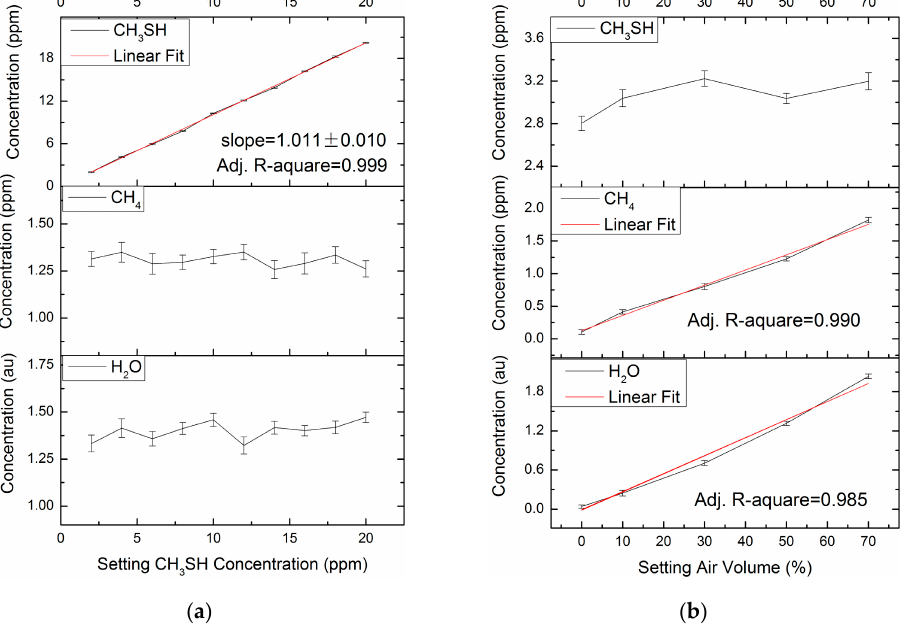
Figure 5. ( a ) Results of a group of mixtures with different CH 3 SH concentrations; ( b ) Results of the other group with different volume fraction of air.